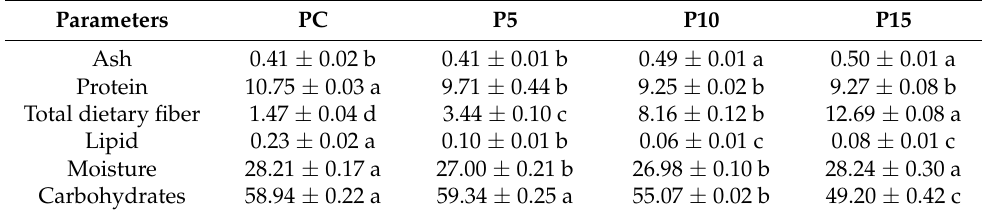
Table 3. Proximate composition of fresh pasta (g/100 g).